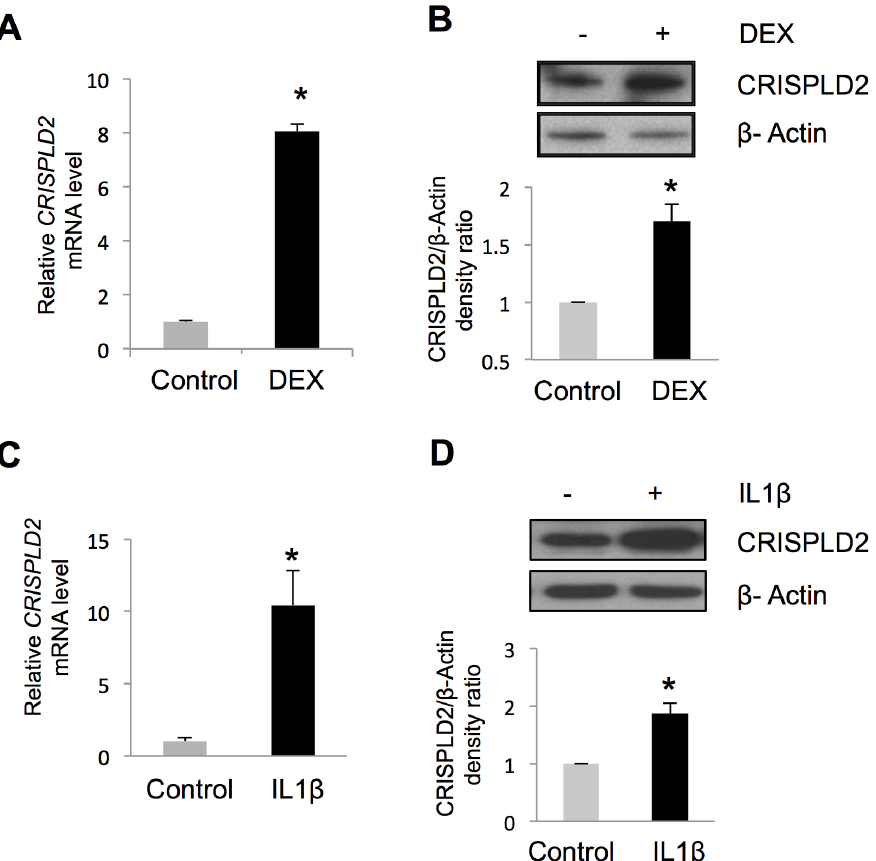
Figure 3. CRISPLD2 is a GC- and IL1 b -responsive gene. ASM cells were treated with 100 nM DEX for 24 h, resulting in A ) increased CRISPLD2 mRNA expression as measured by qRT-PCR, B ) increased CRISPLD2 protein expression as measured by immuno-blotting. ASM cells were treated with 5 ng/mL IL1 b for 24 h, resulting in C ) increased CRISPLD2 mRNA expression as measured by qRT-PCR, and D ) increased CRISPLD2 protein expression as measured by immuno-blotting. CRISPLD2 mRNA levels were measured in triplicate. CRISPLD2 protein levels are shown as normalized blot densitometry values, and the error bars are SE values across three independent experiments. * P , 0.05 ( t test). doi:10.1371/journal.pone.0099625.g003 PLOS ONE |